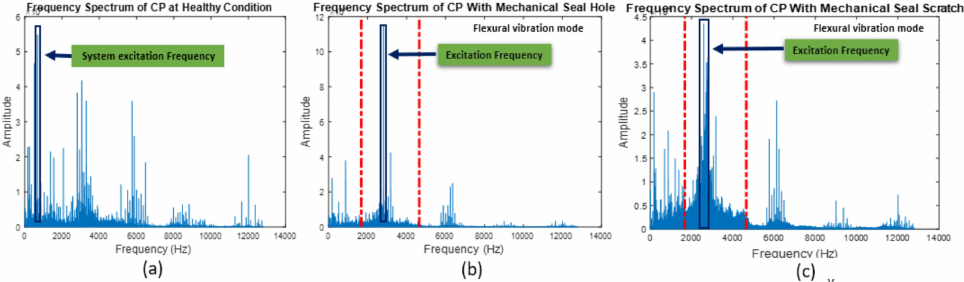
Figure 8. Frequency spectra of the CP under ( a ) normal and ( b ) impeller defect conditions.